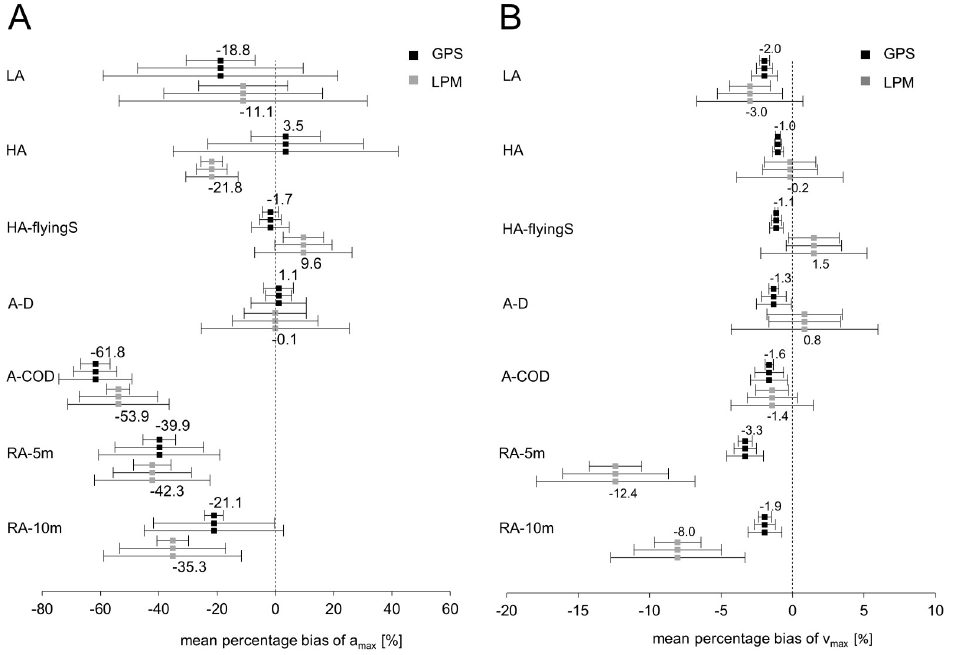
Fig 2. Validity, inter- and intra-unit reliability of maximal acceleration (a max ; A) and maximal speed (v max ; B). Mean percentage bias (MPB; relative bias of the GPS and LPM devices compared to the laser) of a max and v max of 7 different team sport-specific actions indicates the validity of a max and v max . The first whisker of each subcategory within the black and grey squares is the between-device SD of the percentage biases of a max and v max , and represents the inter- unit reliability of a max and v max . The second whisker is the within-device SD of the percentage biases of a max and v max , and represents the intra-unit reliability of a max and v max . The third whisker of each subcategory is the combination of the between- and within-device SD of the percentage biases of a max and v max , which indicates the inter- and intra-unit reliability of a max and v max . If a GPS or LPM device is randomly chosen for repeated measures, the third whisker illustrates the percentage measurement error.